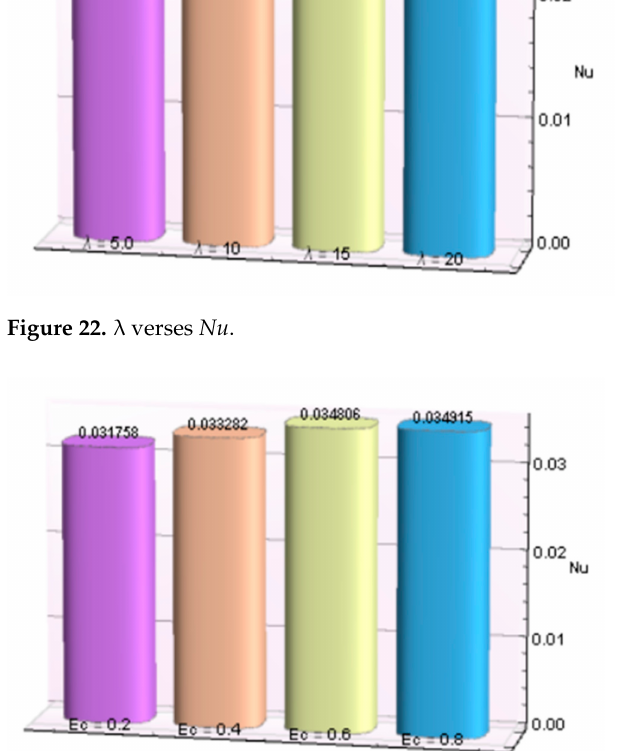
Figure 23. Ec verses Nu